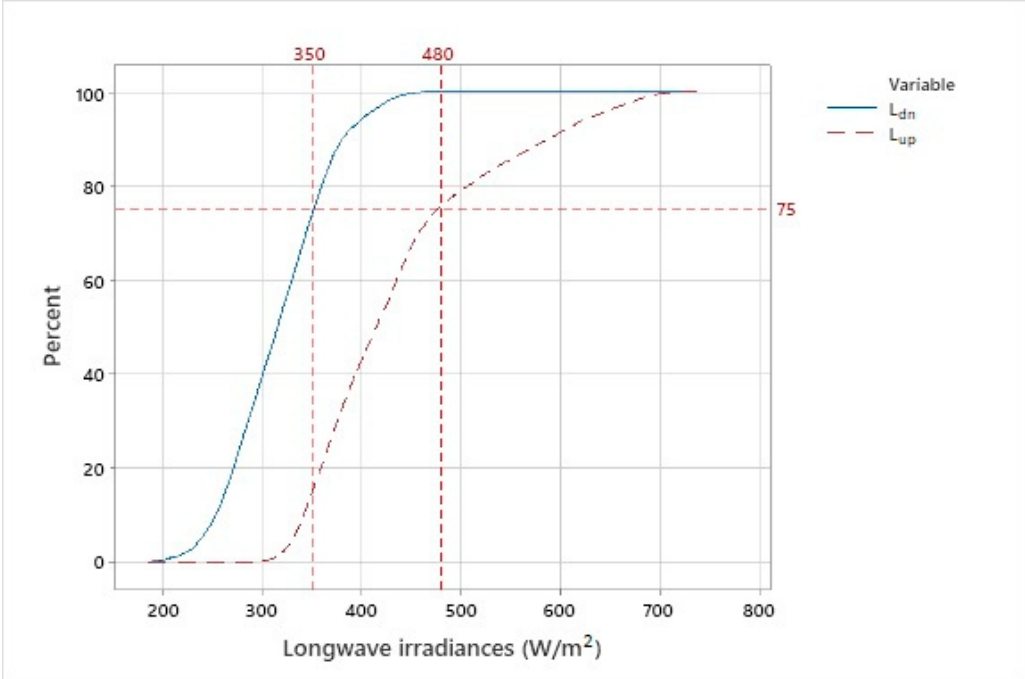
Figure 9. Cumulative density function ( CDF ) for L dn and L up at Athalassa. The monthly variation of both variables is shown in Figure 10. The outliers are pre- sented with an asterisk and as seen, significant number of outliers of L dn is observed in June and during the period of September to November. In the case of L up , outliers are ob- served at the beginning of the year (in the first three months) and towards the end of the year (in the last two months). Figure 10. Monthly boxplots of ( a ) downward ( L dn ) and ( b ) upward ( L up ) longwave irradiances at Athalassa.